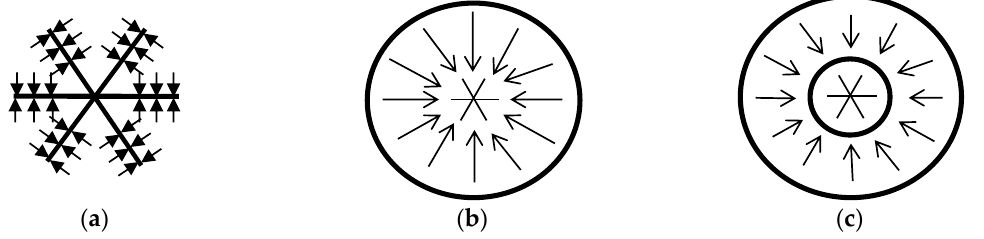
Figure 6. Type curves for the proposed model.